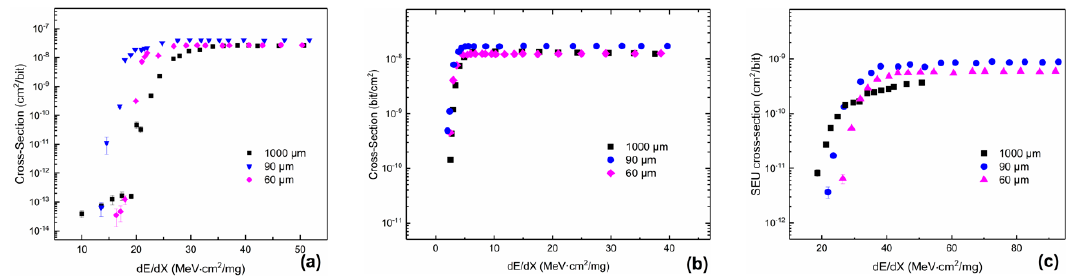
Figure 4. The CS of per bit discrepancy of ( a ) the bulk silicon-hardened SRAM, ( b ) the 6T SOI SRAM, and ( c ) the ADE SOI SRAM with various LETs obtained using heavy-ion computations with di ff erent energy.